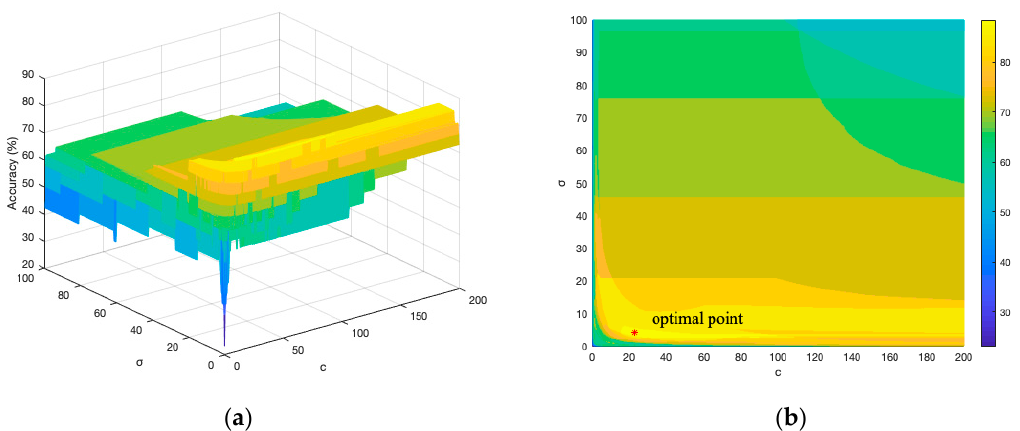
Figure 4. Testing accuracy for all c and σ points. ( a ) 3D visualization of all c and σ and its corresponding testing accuracy. ( b ) Top view of ( a ).